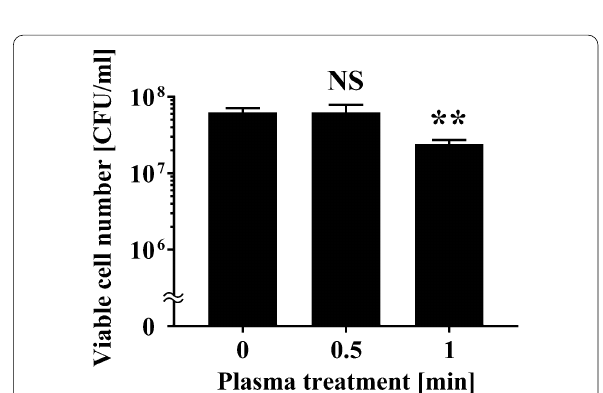
Fig. 8 Viable cell number of P. venetum on the surface of C. unshiu following APDBD treatment. Viable cell numbers of P. venetum , expressed as CFU per ml, on the surface of contaminated C. unshiu at individual APDBD treatment times (0, 0.5, or 1 min) are shown. Differences where p < 0.01(**) versus control (0 min) were considered significant when verified by the non-repeated measured ANOVA followed by the Bonferroni correction. NS means no significant difference compared to Control (0